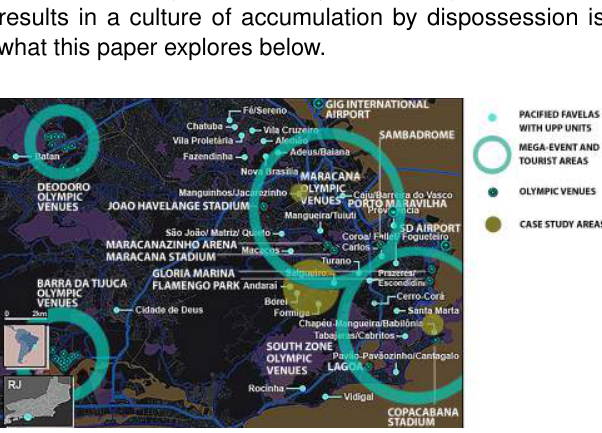
Figure 1. Map of pacified favelas in relation to Olympic venues and tourist